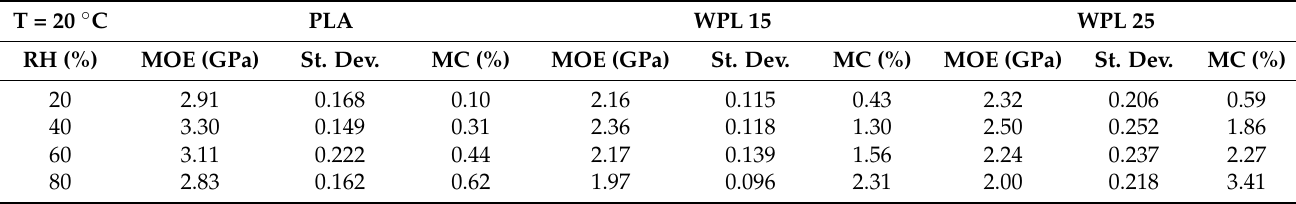
Table 2. Mean modulus of elasticity (MOE) and moisture content (MC) for specimens conditioned at 20 ◦ C between 20% and 80%